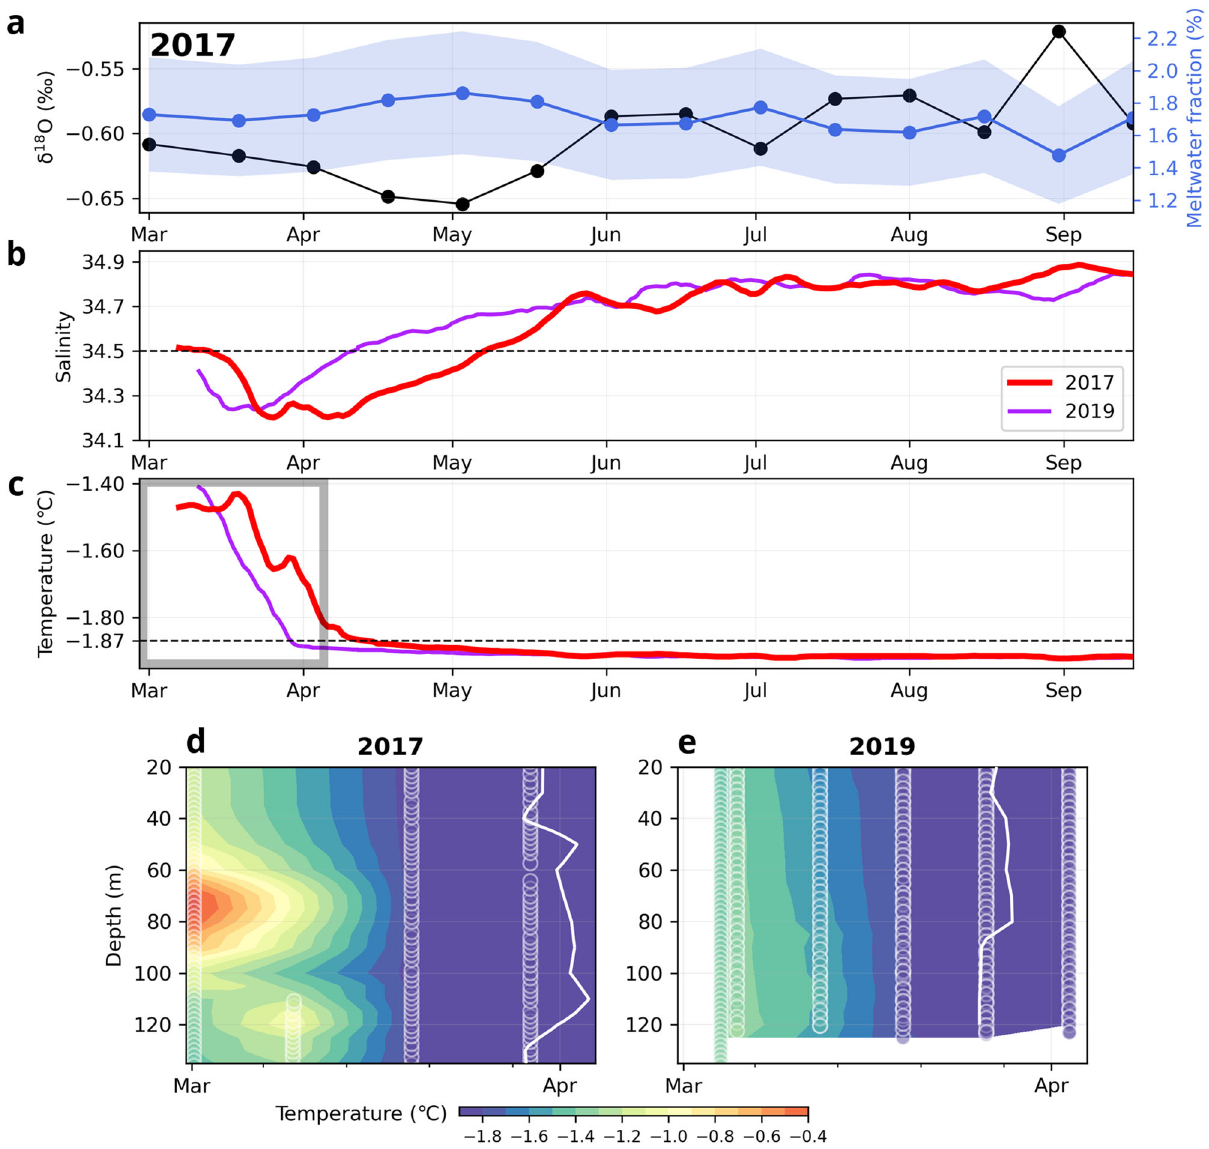
Fig. 4 Seasonal evolution of water properties at CDP. a Oxygen isotope ratio (black) and glacial melt water fraction (blue) in 2017, which was derived from three-point endmember method. b , c are seven-day running mean timeseries of salinity and temperature at 164 m depth in 2017 (red) and 2019 (purple). Broken line at 34.5 in b denotes the salinity criteria of DSW, and that at − 1.87 °C in c denotes the freezing point temperature at a reference salinity in autumn. d , e are the time-depth plots for temperature (color shade) during the period of onset of freezing indicated in c , obtained from the mooring platforms. Data points are shown by scatters. White contour corresponds to the isotherm of − 1.87 °C as a reference temperature. The location of the measurements is indicated by the white cross in Fig.